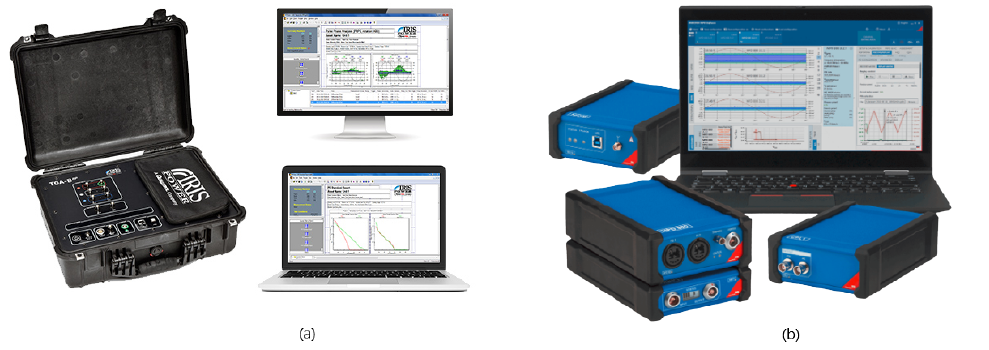
Figure 19. Photograph of commercially available commercial equipment taken in the year 2022 by their manufacturers: ( a ) the TGA-B of IRIS Power [49] and ( b ) the MPD 800 of OMICRON